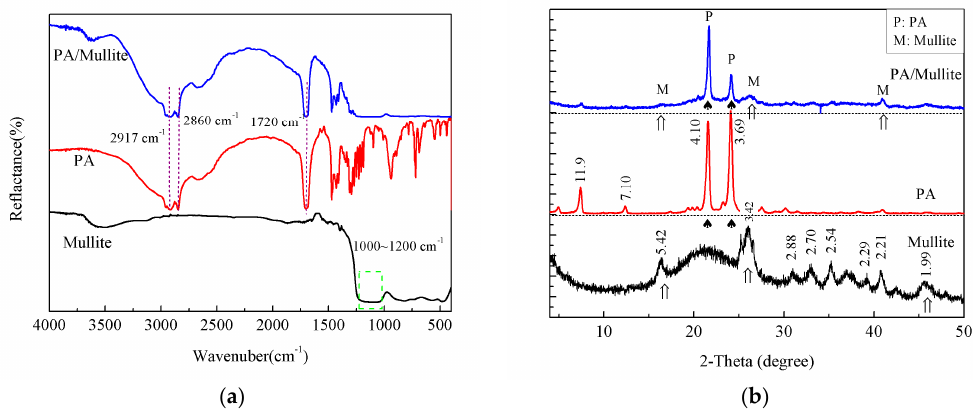
Figure 3. ( a ) Fourier Transform Infrared Spectroscopy (FTIR) spectra and ( b ) X-Ray Diffraction (XRD) patterns of the PA, mullite, and PA/mullite composite.